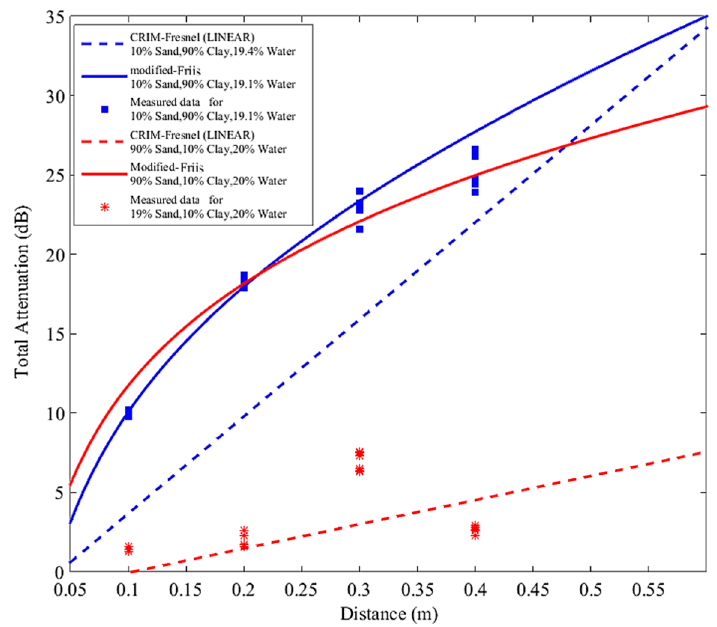
Figure 4. Comparison of the radio frequency (RF) models for two soil mixtures.